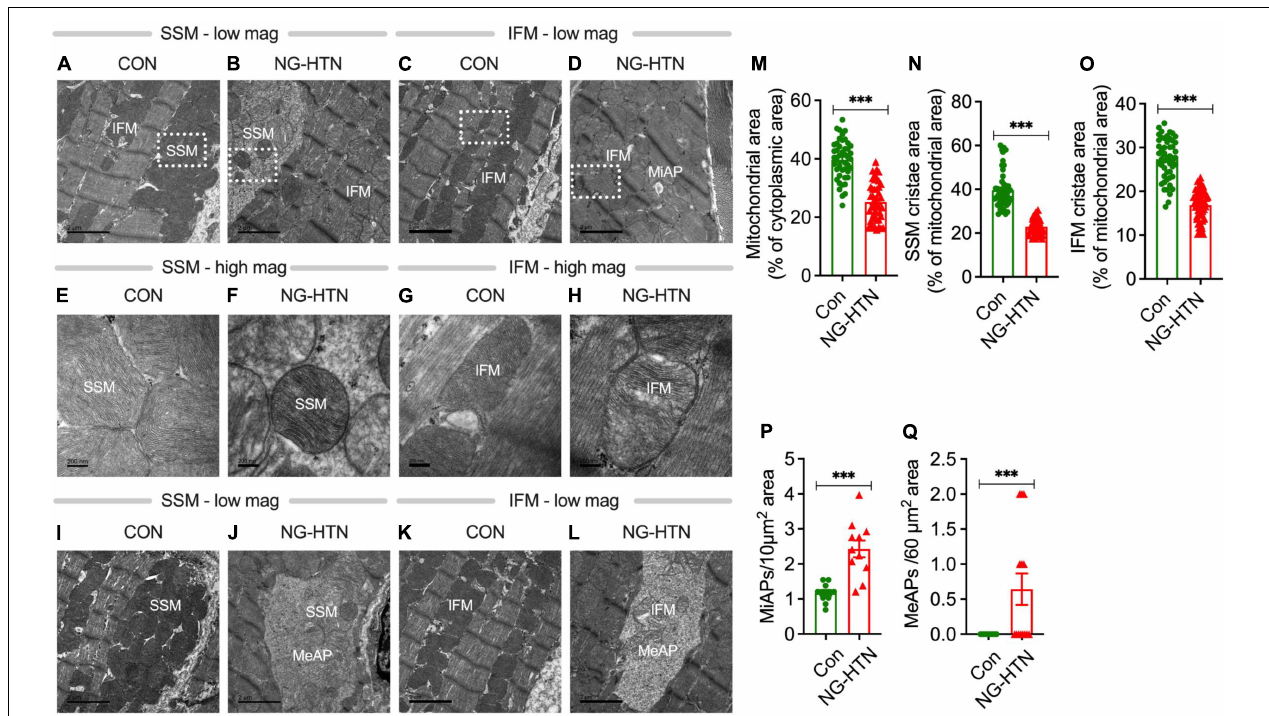
FIGURE 3 | Neurogenic hypertension and cardiac mitochondrial injury. (A–D) Low magnification EM micrographs showing mitochondrial population and microautophagosomes. (E–H) Higher magnification of a selected area in (A–D) showing the mitochondrial ultrastructure abnormalities. (I–L) Low magnification EM micrographs showing macroautophagosomes. Morphometric analyses: (M) mitochondrial area, (N) SSM cristae area, (O) IFM cristae area, (P) , microautophagosomes, and (Q) macroautophagosomes. Mitochondrial area was calculated from 15 micrographs per rat heart (dot represents 45 individual mitochondria counts), n = 3 rats. Cristae area was calculated from at least 15 micrographs from each rat (dot represents 50 individual mitochondria counts), n = 3 rats. Microautophagosomes were calculated from 11 micrographs representing n = 3 rats, dot represents numbers per unit area. Megaautophagosomes were calculated from 14 micrographs representing 3 rats, dot represents numbers/unit area. *** P < 0.001 vs. Control, Student’s t -test. Scales bars: (A–D) , 2 nM; (E–H) , 200 nM; and (I–L) , 2